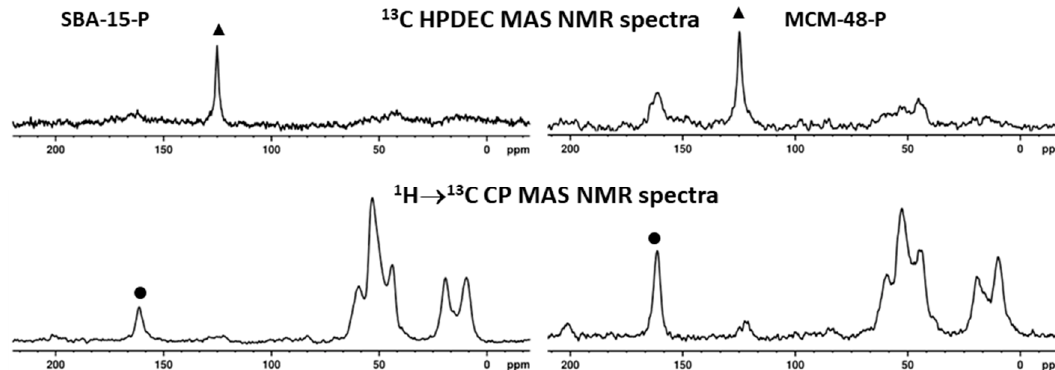
Figure 6. 13 C high power 1 H decoupling ( top ) and 1 H − 13 C CP spectra ( bottom ) of 13 CO 2 adsorbed on SBA-15-P ( left ) and Figure 6. 13 С high power 1 H decoupling ( top ) and 1 Н − 13 С CP spectra ( bottom ) of 13 СО 2 adsorbed on SBA-15-P ( left ) and MCM-48-P ( right ). ( • ) chemisorbed CO 2 ; ( (cid:78) ) physisorbed CO 2 МСМ -48-P ( right ). ( • ) chemisorbed CO 2 ; (  ) physisorbed СО 2 .